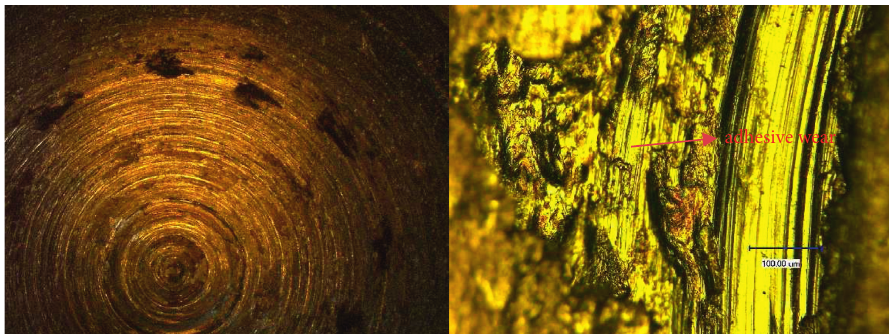
Figure 13: Dry grinding morphology diagram of the optimal orthogonal sample